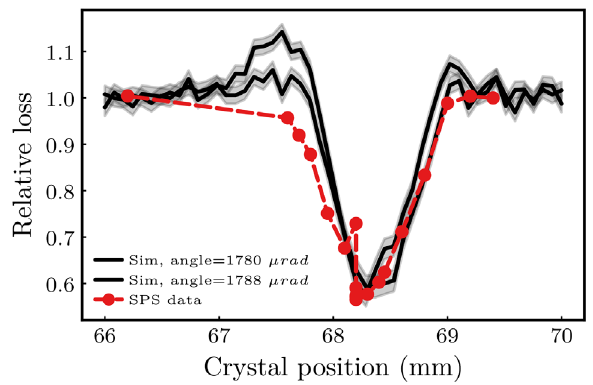
FIG. 15. Relative beam loss measured on the BLMs next to the ES as a function of the crystal position when aligned to the beam in channeling. Simulations for different angles are plotted to show the fluctuations in losses with the chosen angle, as this contrib- utes to the uncertainty in the prediction of the loss reduction. The horizontal axis is expressed in MAD-X reference